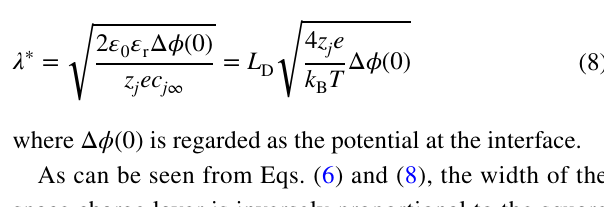
Fig. 3 Order of lattice mismatch with different interfacial structures: coherent interface, semicoherent interface and incoherent interface. Reproduced with permission from Ref. [36].Copyright 2008 Royal Society of